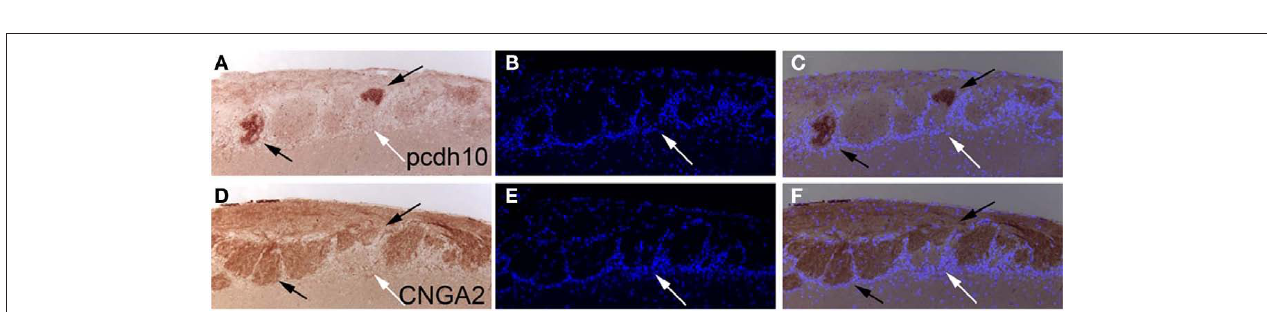
Alternating section stained with an anti- CNGA2 antibody demonstrating overlap with pcdh10 -positive glomeruli. Some glomeruli do not express pcdh10 or CNGA2 (white